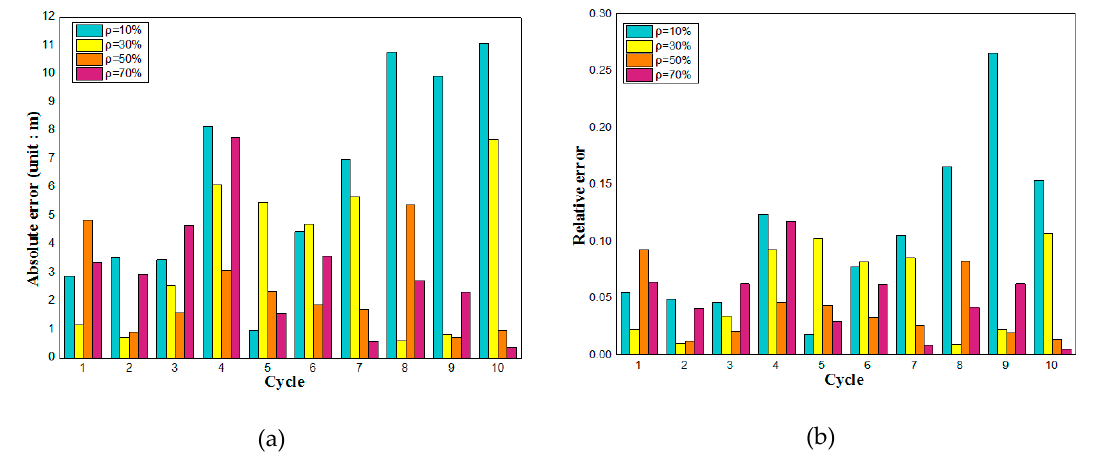
Figure 10. Absolute error of combined sensing model (a) and relative error of combined sensing model (b) .